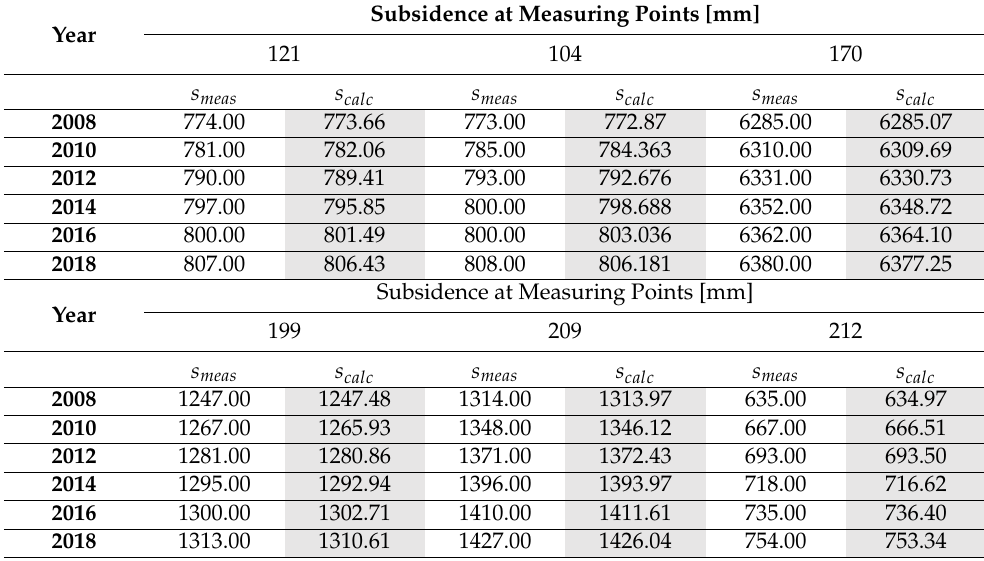
Table 3. Results of the subsidence obtained using the Gauss–Markov equalization algorithm in analyzed